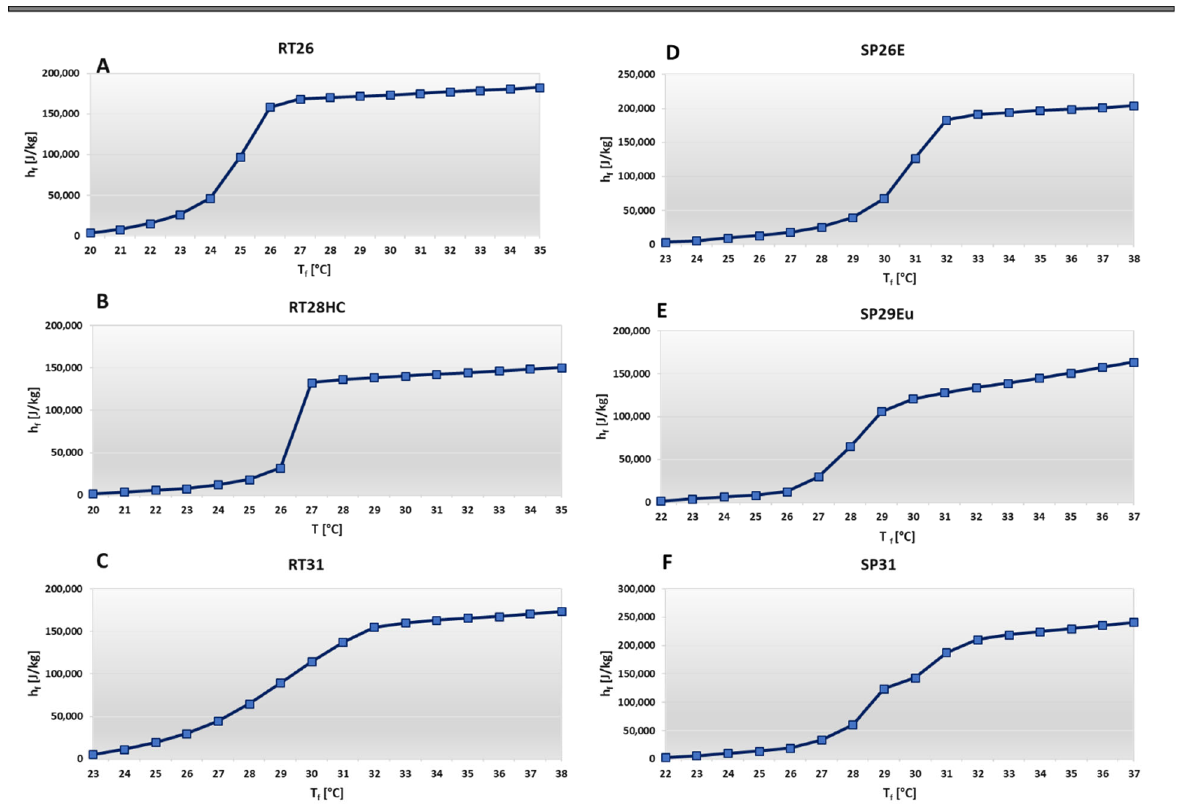
Figure 4. Enthalpy–temperature function of: ( A ) RT26 ® ; ( B ) RT28HC ® ; ( C ) RT31 ® ; ( D ) SP26E ® ; ( E ) SP29Eu ® ; ( F ) SP31 ® .